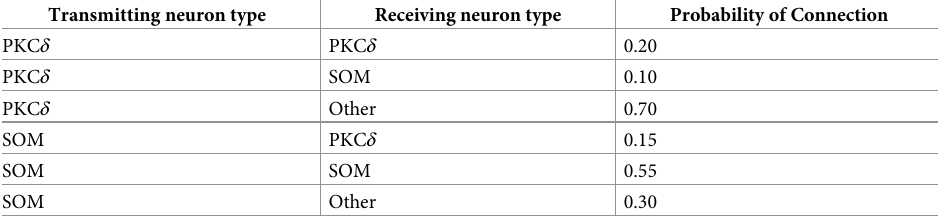
Table 3. Probabilities associated with the creation of neural connections (e.g., directed links) transmitting signals from a PKC δ or SOM neuron to another neuron in the model. These probabilities were estimated from previously published